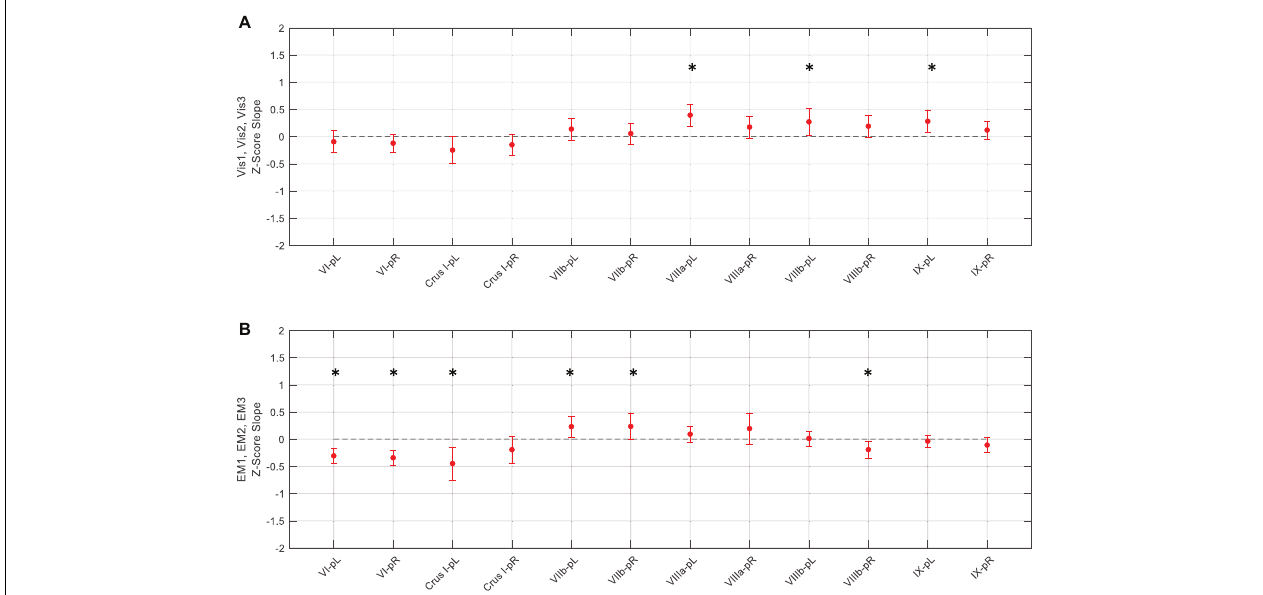
FIGURE 8 | Slopes of the evolution of average response strengths (red dots) for the task-positive ROIs from Figure 5 as a function of task repeats for the Vis task ( upper panel A ) and EM task ( lower panel B ). Note that for the Vis task sequence (A) , three ROIs in the left lobules VIIIa, VIIIb, and IX had significant positive slopes - increasing response strength as the learning progressed. In contrast, the EM task sequence (B) , showed both significant decreases and increases in different ROIs during learning. Error bars are 95% confidence intervals for the difference of the slopes from a zero-slope; asterisks indicate significant slopes at p < 0.05.